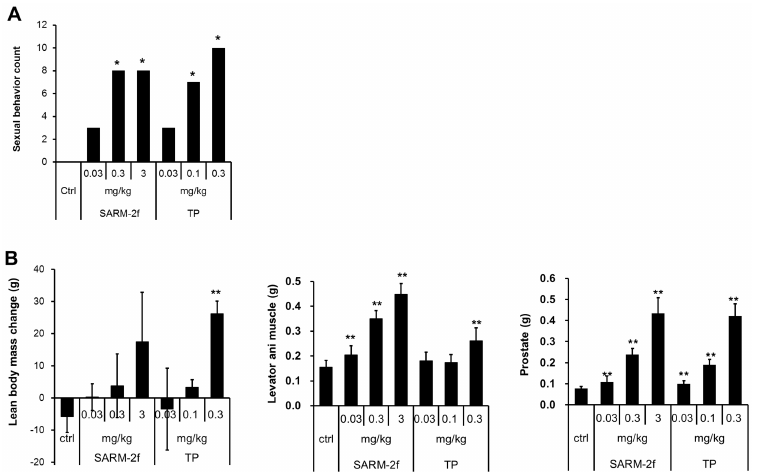
Fig 5. Induction of sexual behavior by SARM-2f and TP in castratedmale rats. (A) Sexual behavior scores. (B) Lean body mass change and levator ani muscle weight (g), lean body mass. The drug was administered to castrated male rats for three weeks. Sexual behaviorwas determined by observation of the estrous cycle of female rats that had been mated with male rats treated with SARM-2f or TP at the end of the treatment period. (n = 10). * P < 0.05 vs. the control group with a Fishers’ exact-test. ** P < 0.005 vs. control group with the Williams test. Ctrl, Controlvehiclegroup, TP, testosteronepropionate.